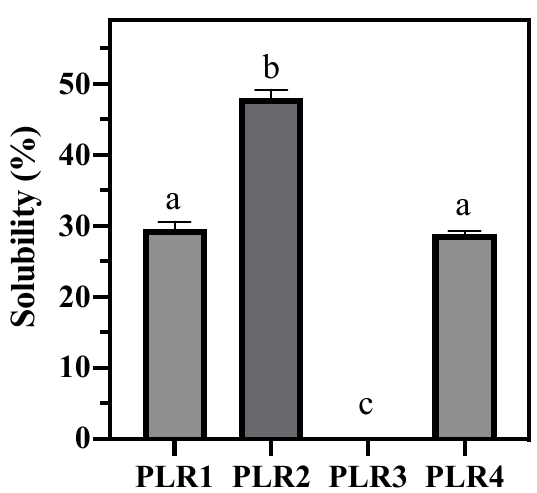
Figure 3. Water solubility of spray-dried powders. Same letter means no significant difference according to Tukey’s multiple comparison test ( p < 0.05).